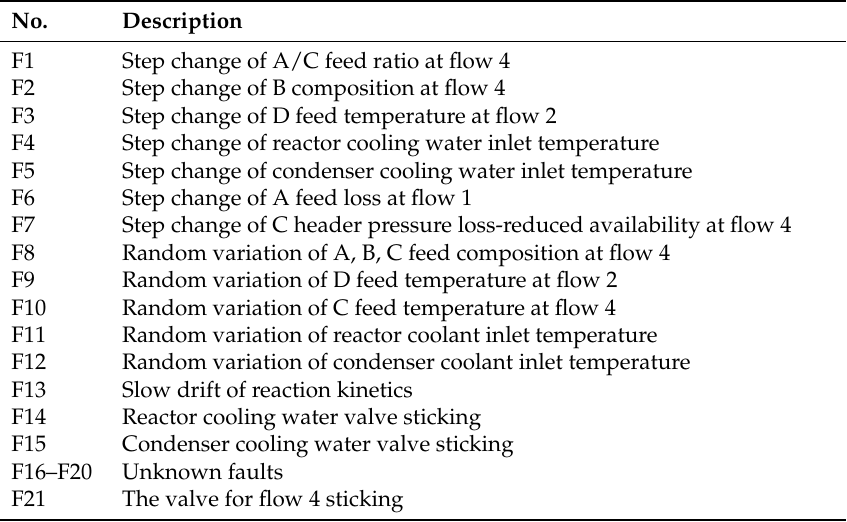
Table 1. Process faults of the TE